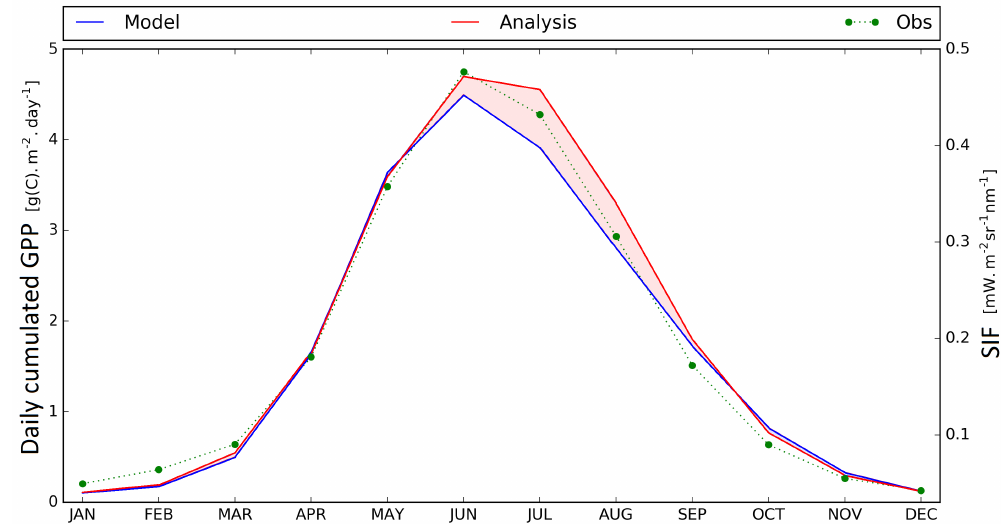
Figure 7. Seasonal monthly time series of the SIF observations (green, right-axis), open-loop (blue, left-axis) and analysis (red, right-axis) GPP simulations from 2007–2015 averaged over the Euro-Mediterranean area.